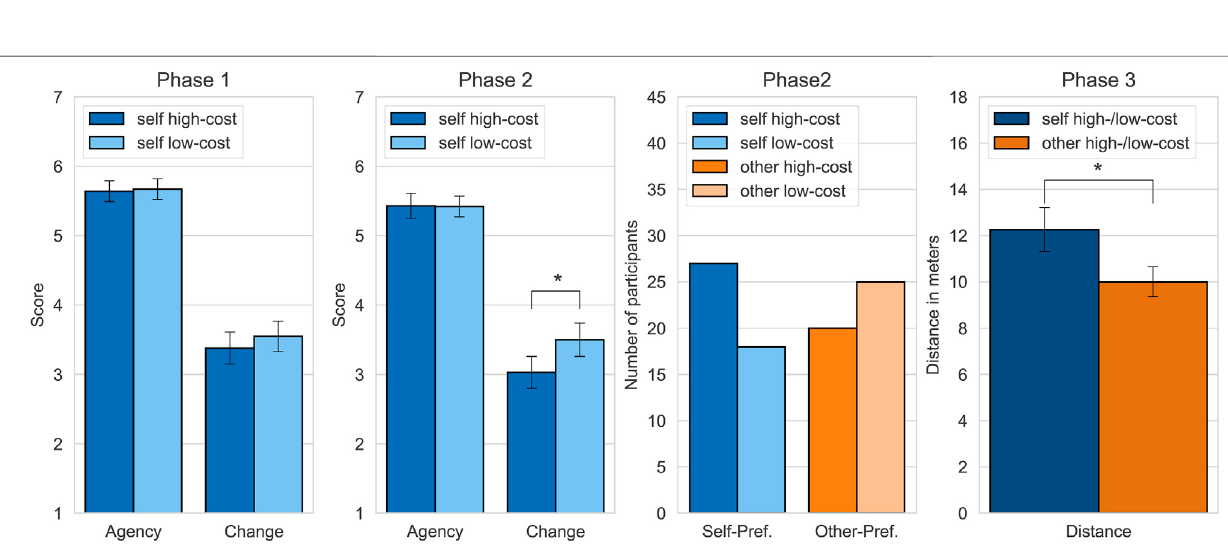
FIGURE 6 | From left to right: Means and standard errors for the VEQ subscales Agency and Change for phases 1 and 2. Preference for the low-cost or high-cost self-avatars and virtual others in the number of participants who chose the respective version. Distances in meters at which participants could no longer say that one of the versions was better. p <